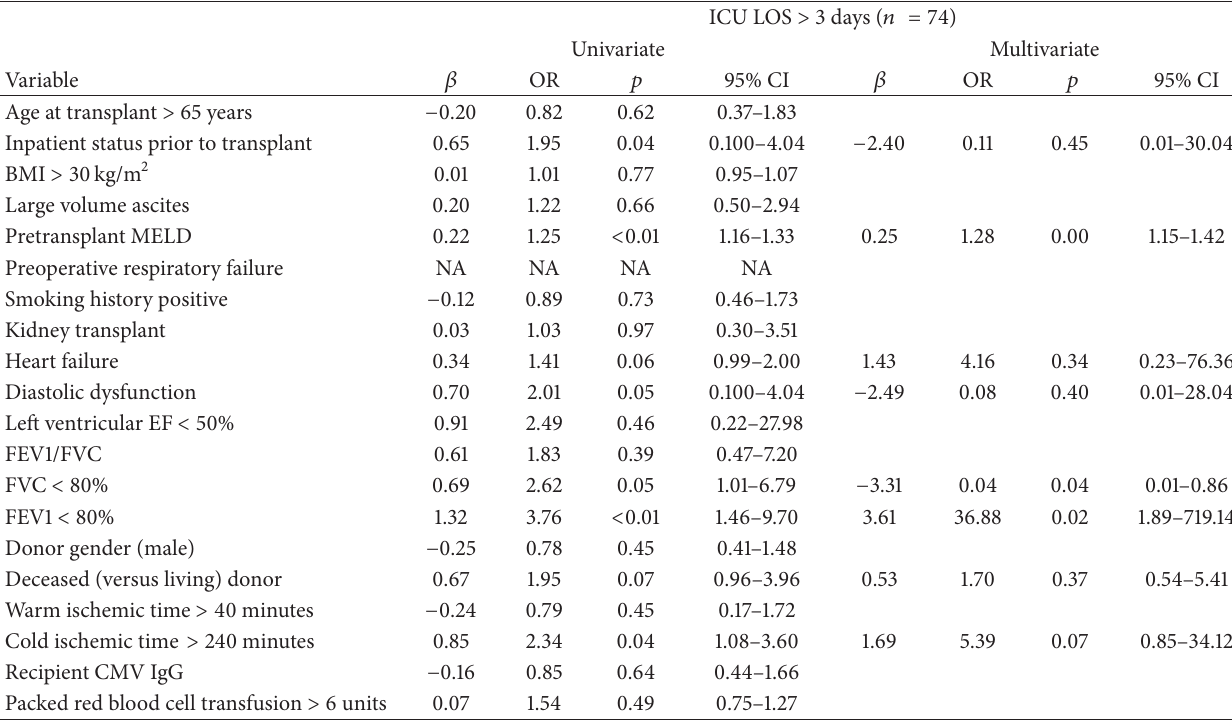
Table 3: Univariate and multivariate analysis of ICU